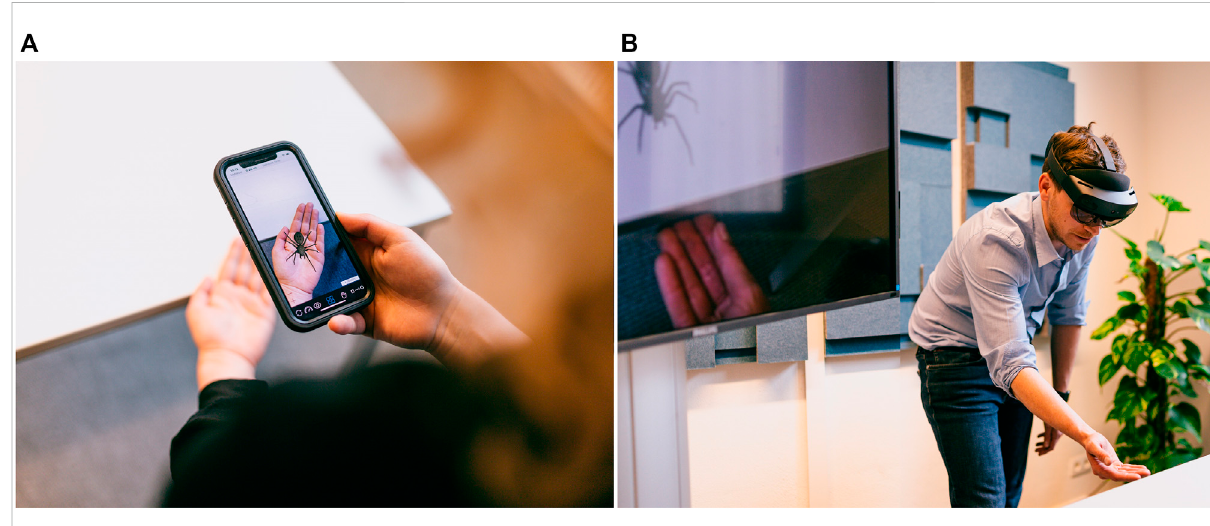
FIGURE 1 Visualization of the last step from the Behavioral Approach Task in the smartphone (A) and HoloLens 2 condition (B)